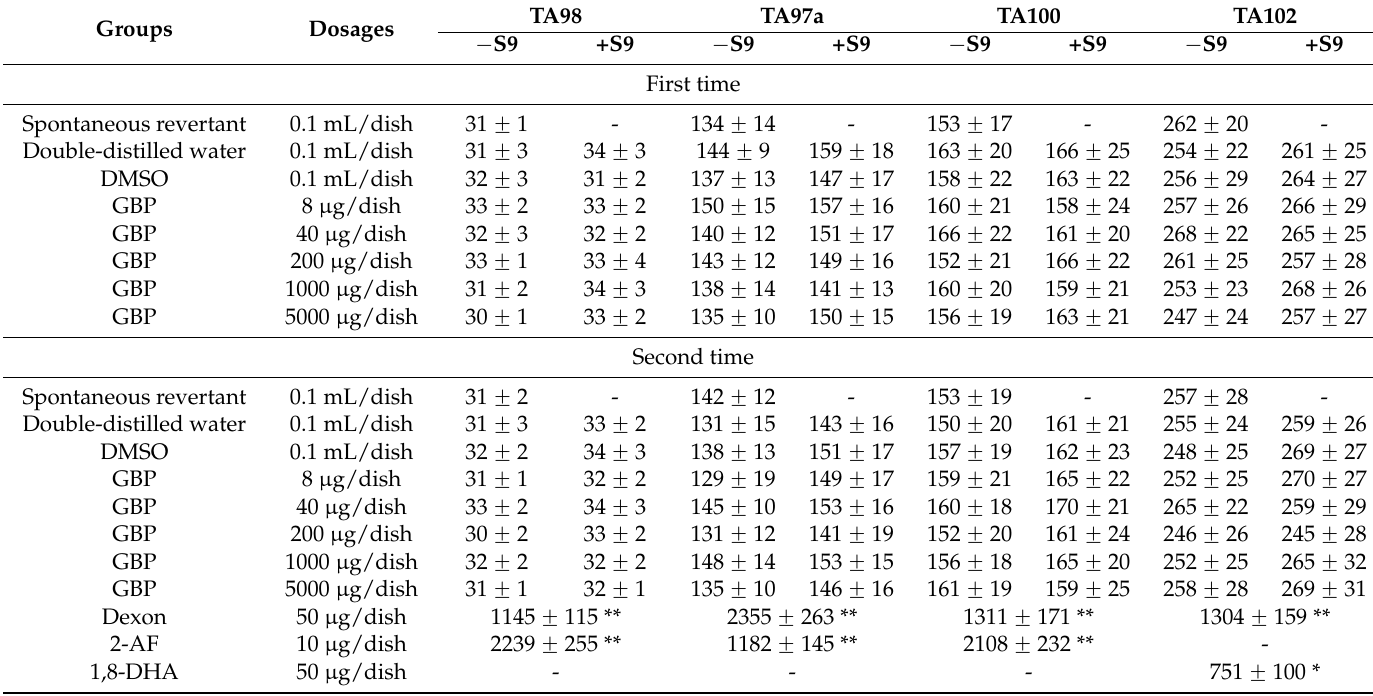
Table 4. Effects of GBP on revertant colonies of the standard strains in vitro (x ˘ s, n =